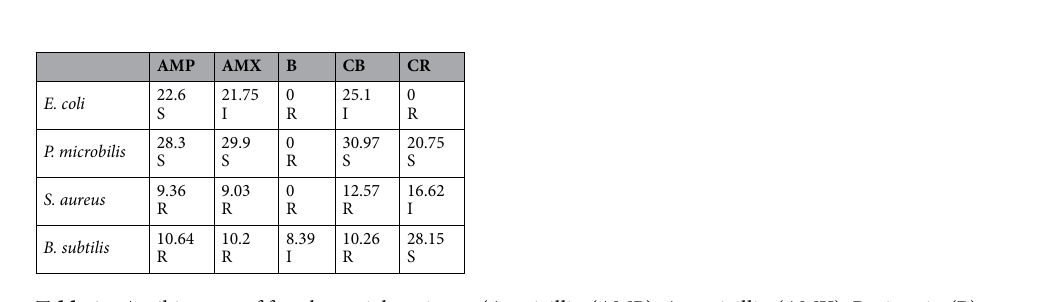
Table 2. Antibiogram of four bacterial strains to (Ampicillin (AMP), Amoxicillin (AMX), Bacitracin (B), Carbenicillin (CB), and Cephalothin (CR)) (S: susceptible, R: resistant, I: intermediate).